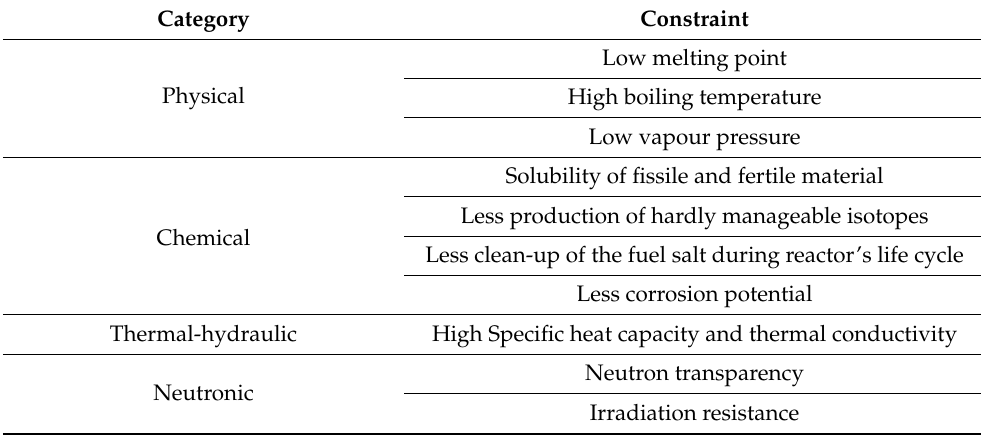
Table 3. Key constraints of molten salt fuel.